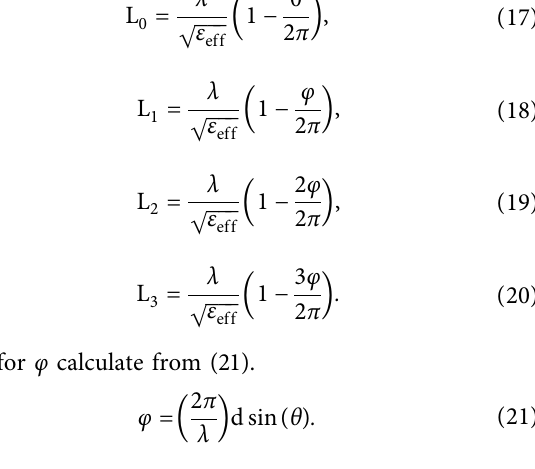
Figure 7: Grouping antennas into a sub-array